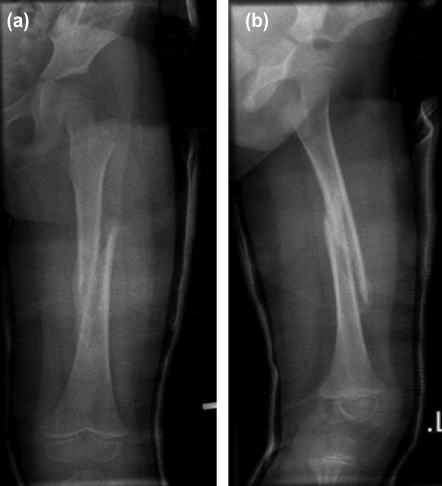
(a,b) Radiographs showing loosening of the initial cast around the thigh especially proximally after four weeks for patient A. Fig. 2: